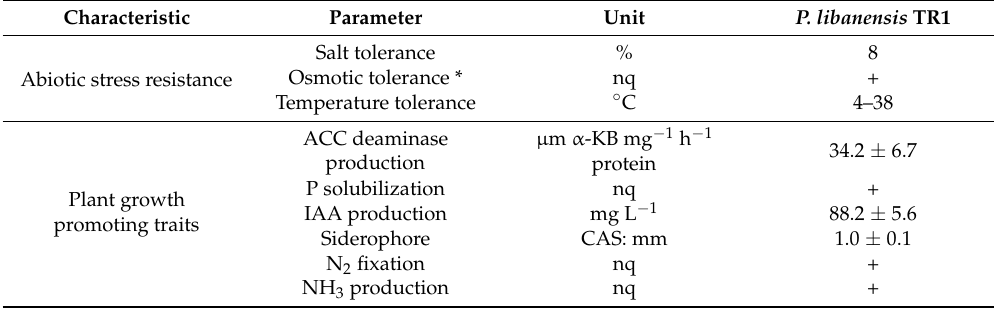
Table 1. Biochemical characteristics of Pseudomonas libanensis